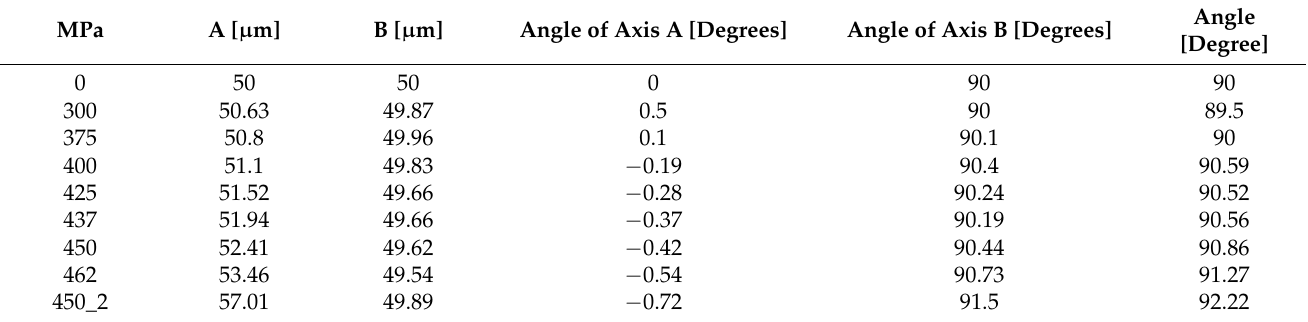
As a result of the tests, the meso deformation in the long inclusion in the tensile specimen was calculated. The results of meso-scale deformation are presented in Table A1. Table A1. Change in the length of the account of the selected area and angle at the meso plane for the tensile specimen.